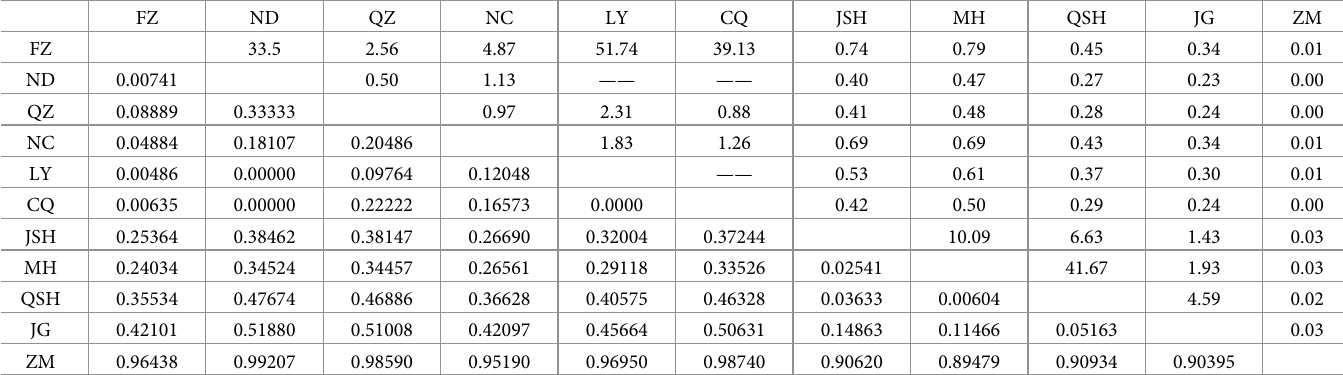
Table 2. Gene flow ( Nm ; above the diagonal) and differentiation coefficient ( Fst ; below the diagonal) between populations. FZ